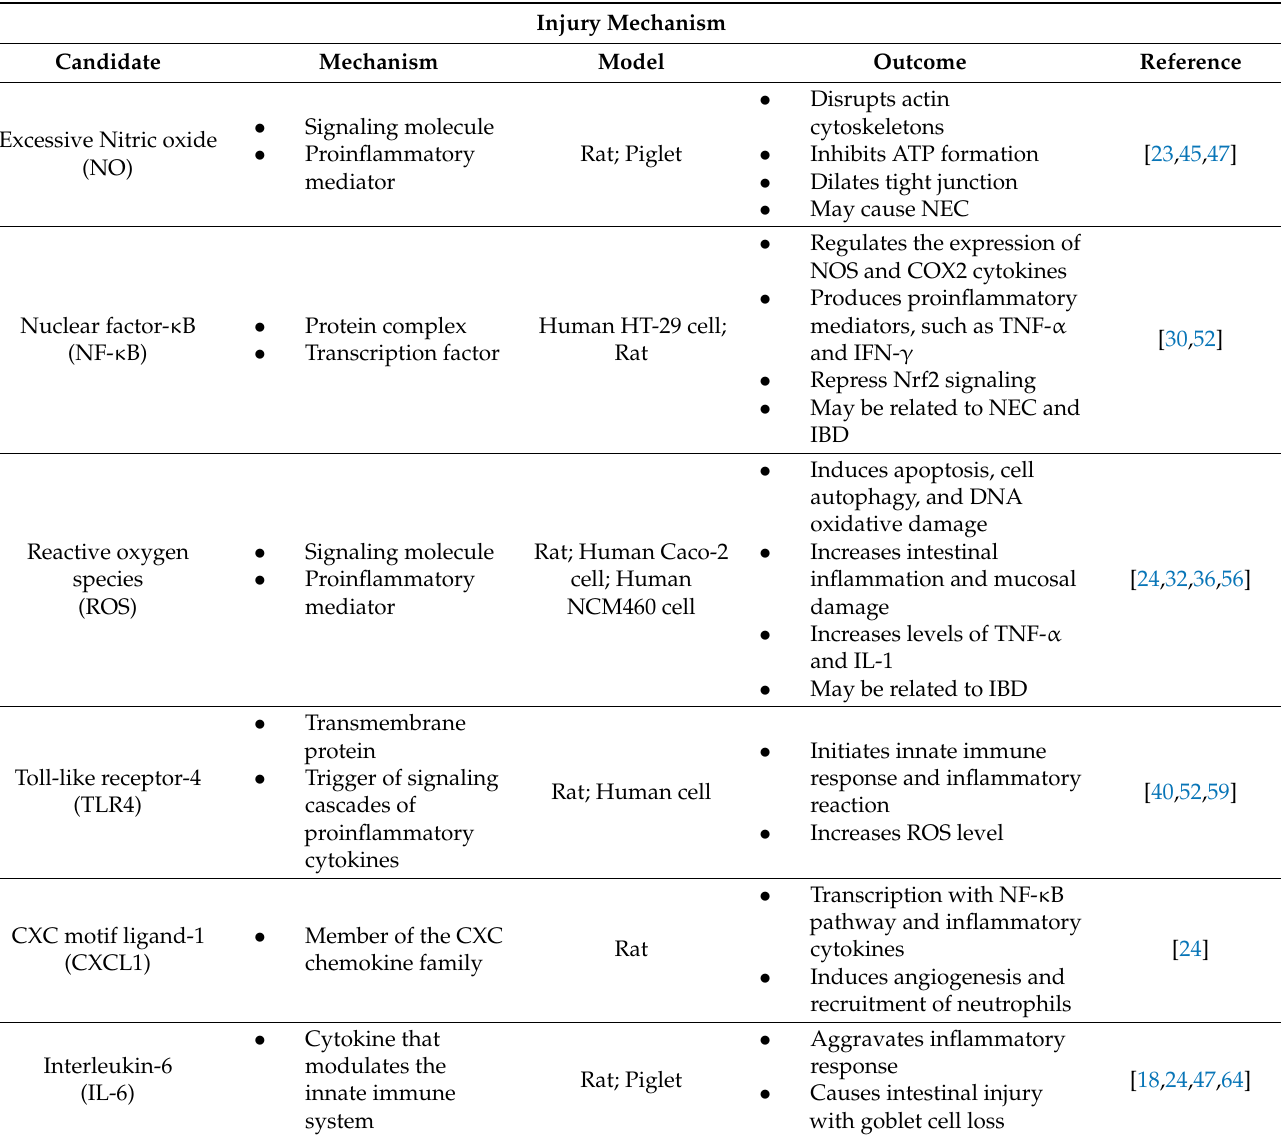
Table 1. Evidence of the roles of various molecules in the intestine under hyperoxic conditions. Injury Mechanism Model Outcome